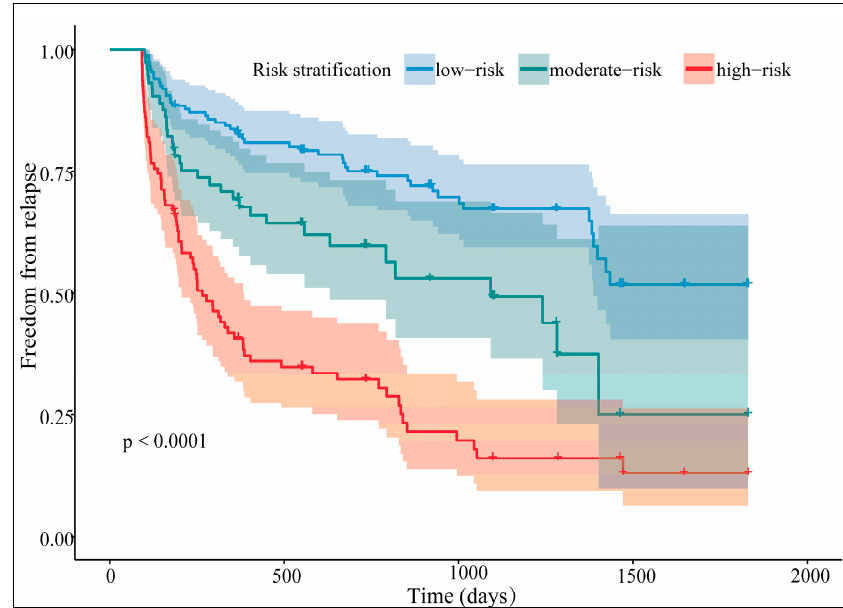
Figure 8. The nomogram-based risk stratification.